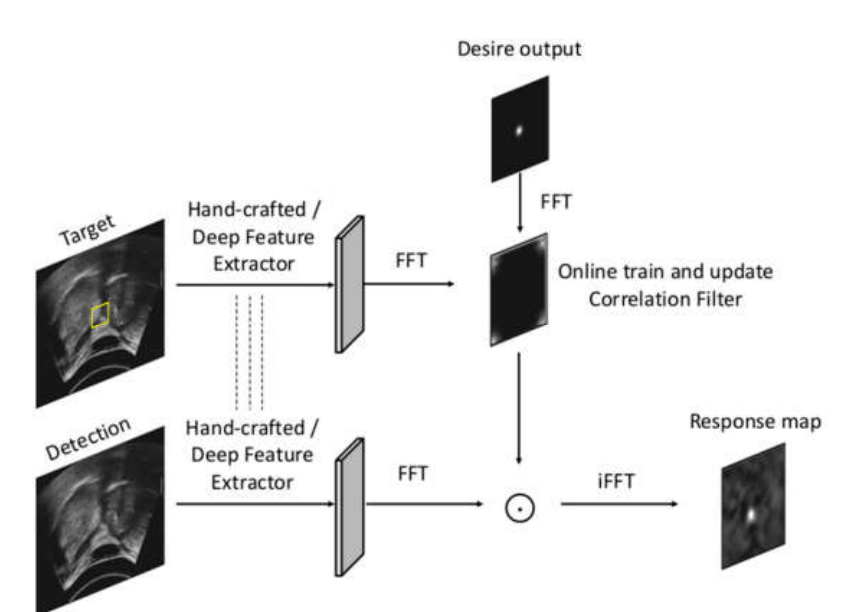
Figure 4. Workflow of correlation filter trackers.